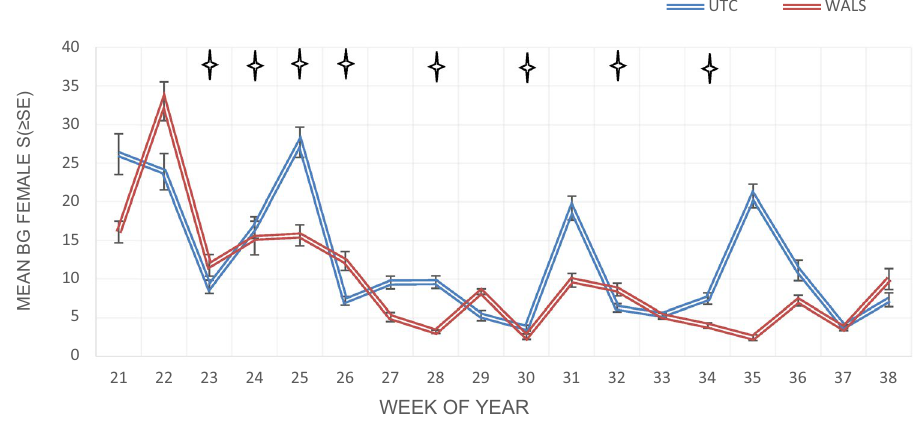
Fig. 9 Mean Total female and male Ae. aegypti collected from the BG-Sentinel 2 trap in the untreated control (Blue) and the treatment (Red). Star indicates Vectobac WDG